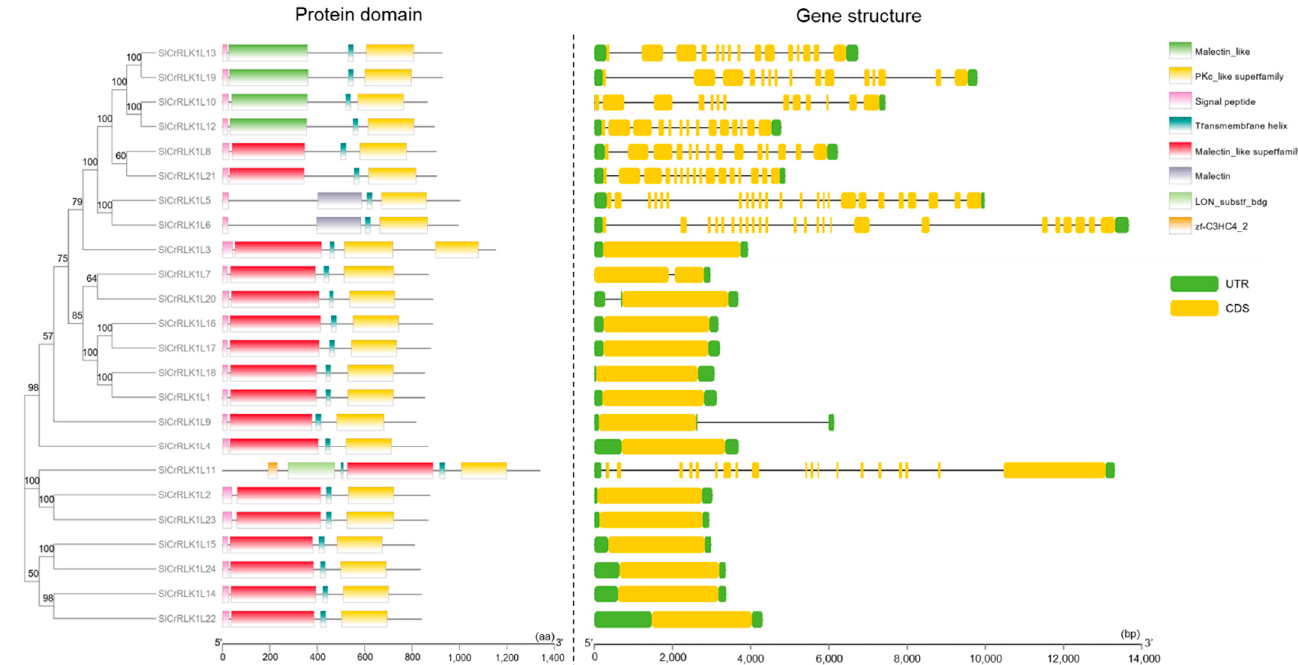
Figure 4. Protein domains and gene structures of SlCrRLK1Ls. The signal peptides, malectin-like domains, transmembrane helices, kinase domains, UTRs, and CDSs are marked in different colors.